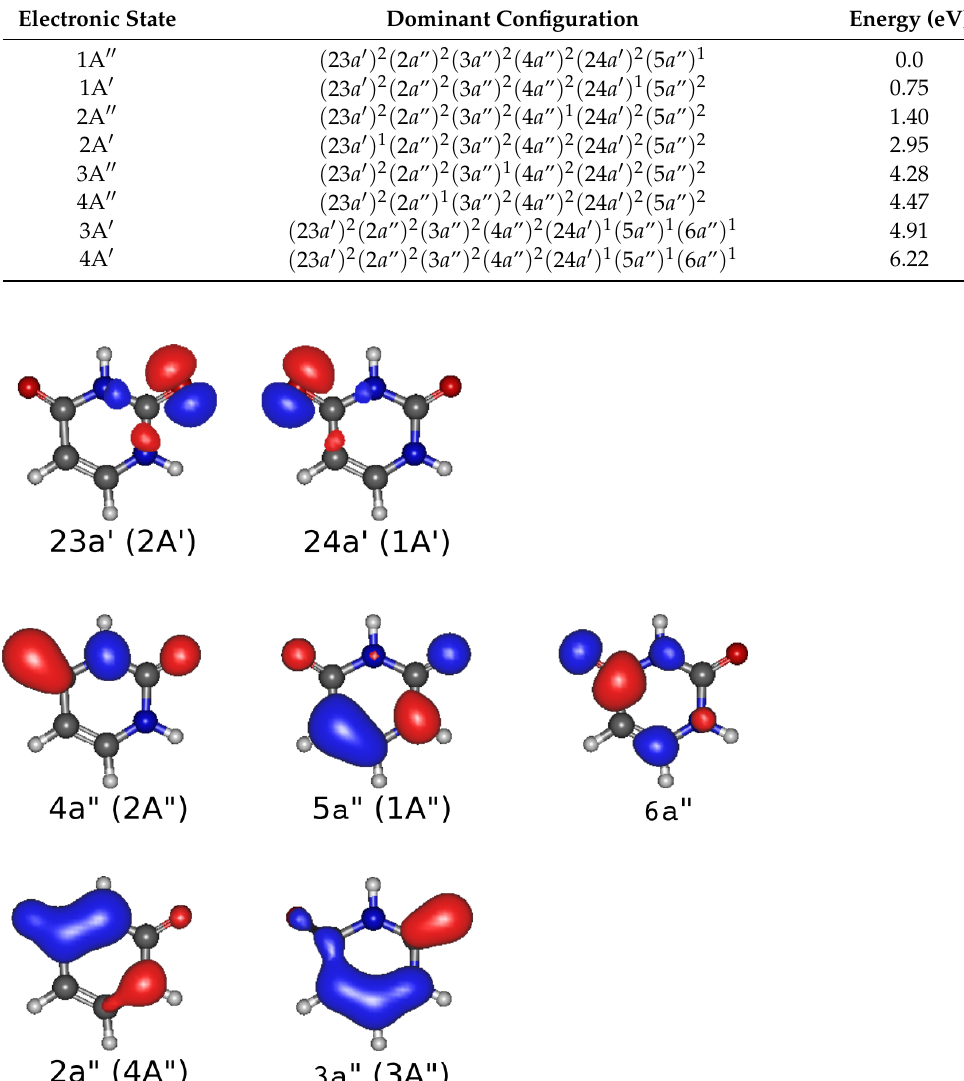
Figure 5. Natural orbitals of the uracil cation obtained with the CASSCF calculations when the projectile is at asymptotic distances along the t2d trajectory. The labels underneath each orbital refer to the sequence number of the orbital within its symmetry in the Cs point group, and the bracket contains the U + electronic state of the uracil cation (see Table